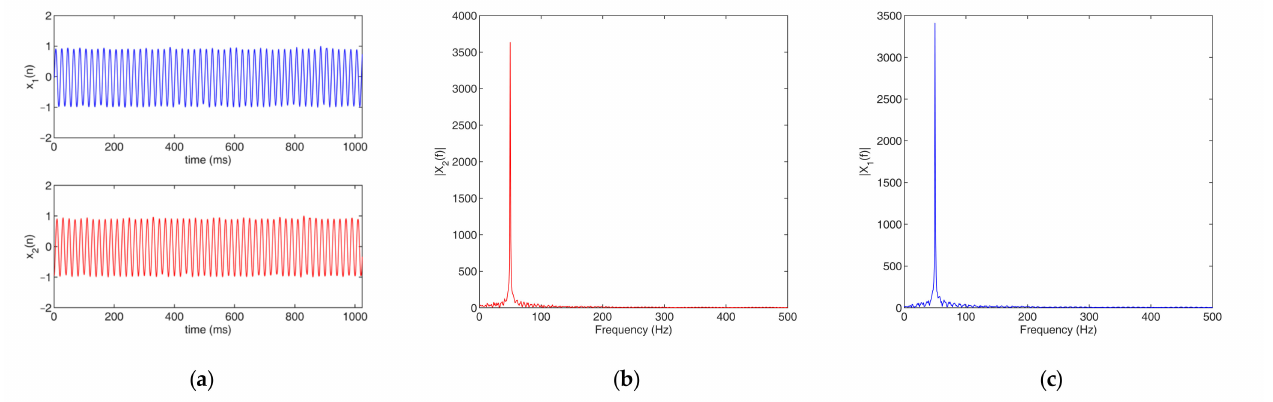
Figure 3. A typical example of signals with strong periodicity: ( a ) signals; ( b ) spectra of x 1 ( t ) ; ( c ) spectra of x 2 ( t )